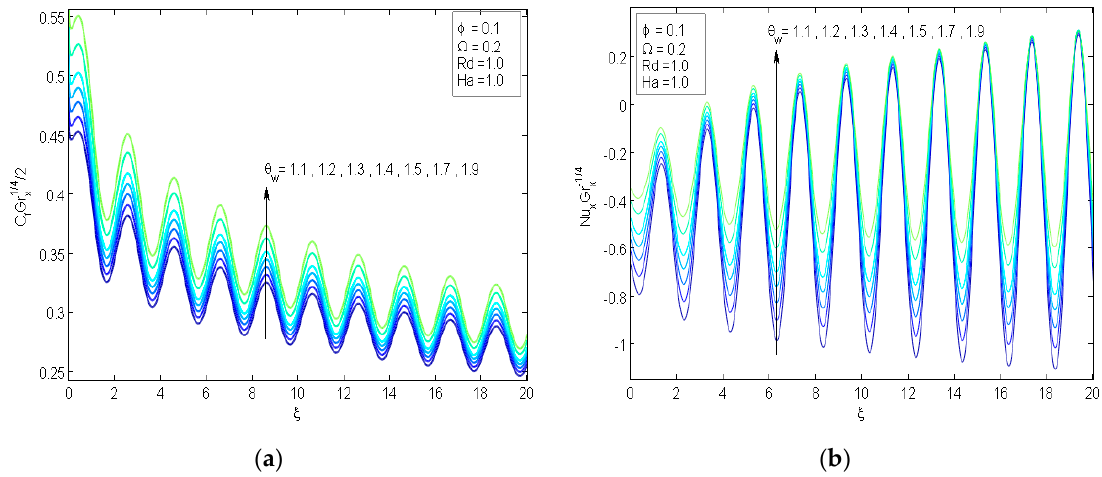
Figure 8. The effectiveness of θ w on drag coefficient ( a ) and on Nusselt number ( b ).